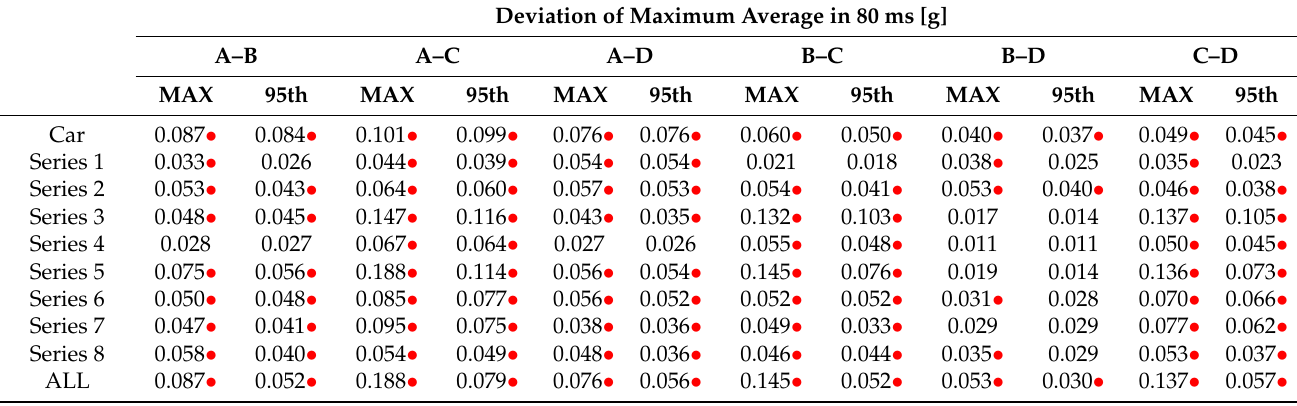
Table 4. A comparison of maximum deviations and 95th percentiles for sensors A–D and individual series of measurements. Deviation of Maximum Average in 80 ms